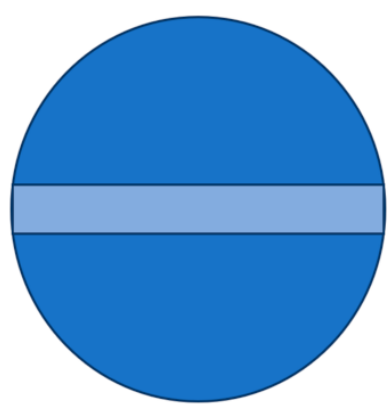
Figure 9. Snapshots of particle positions of the − 9.5 + 8.0 mm for single and double rotor environ- ments both operating at 1040 rpm impeller speed. ( a ) Frame 30 single rotor. ( b ) Frame 30 double rotor. ( c ) Frame 60 single rotor. ( d ) Frame 60 Double rotor.